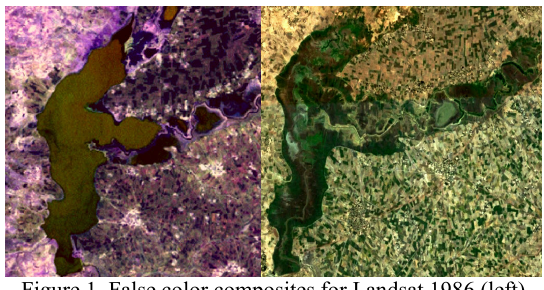
Figure 1. False color composites for Landsat 1986 (left) and 2002 (right) Fig. 2. Category “Water lily” on the surfaces of the lake recognized in 1989 is shown in Fig.3.